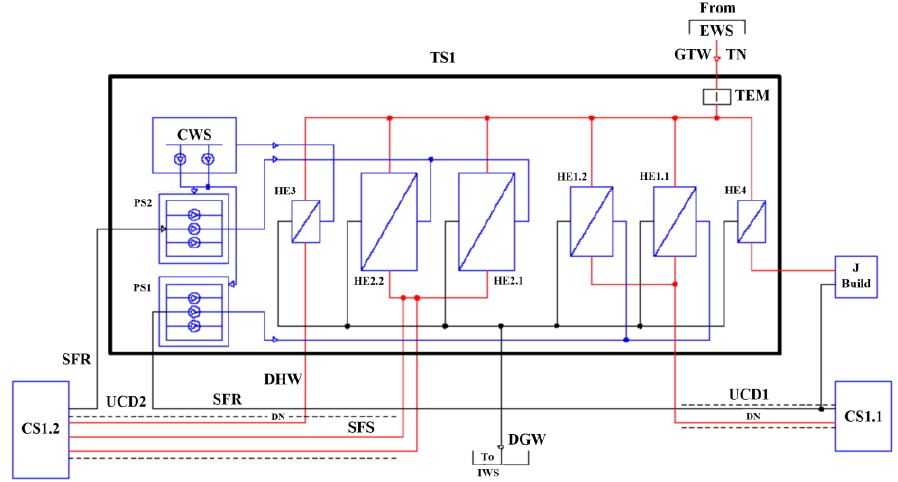
Figure 2. Main thermal station diagram (TS1): DHW — domestic hot water; PS1, PS2 — pumping sta-